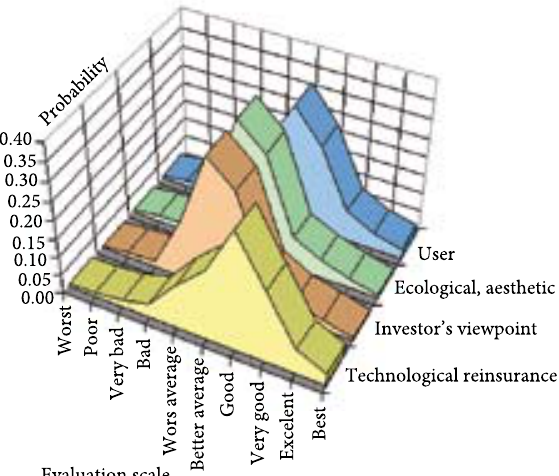
Fig. 5. Graph of a variant evaluation: steel